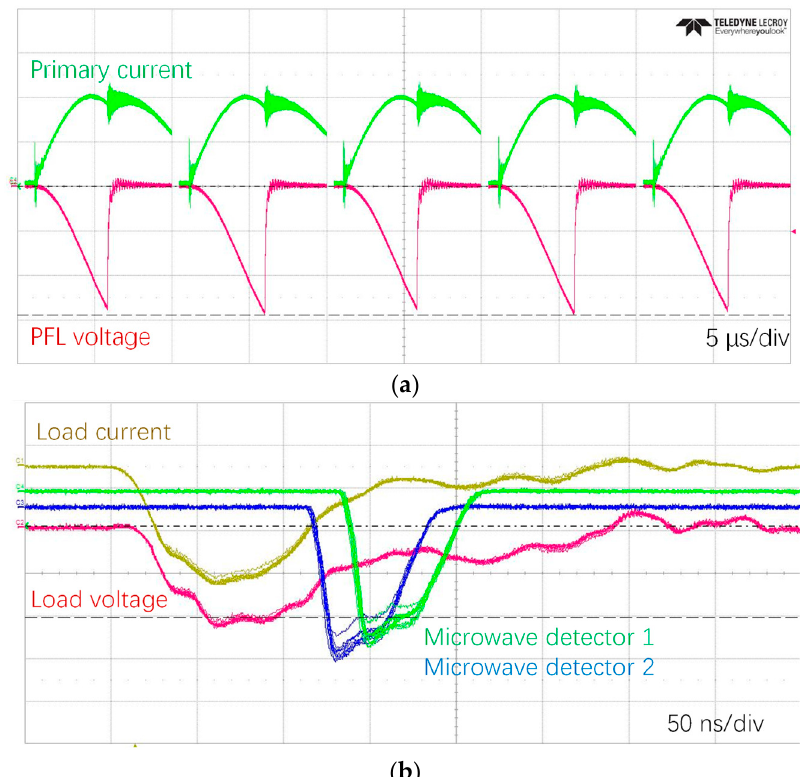
Figure 13. Experiment waveforms of the 5 Hz rep-rate test: ( a ) the primary current of the transformer and PFL voltage; ( b ) the load current, load voltage, and microwave detector signals.